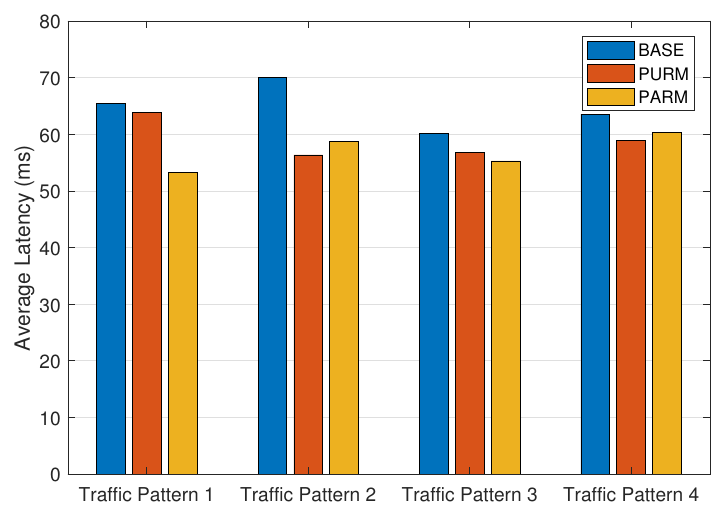
Figure 11. Comparison of application’s average